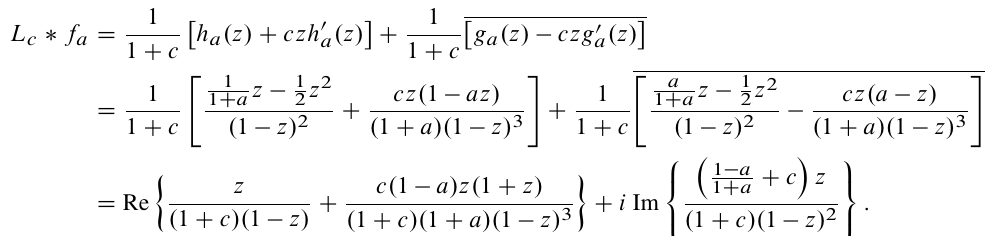
Fig. 3. Images of U under f 0:5 ;L 6 and L 6 (cid:3) f 0:5 .